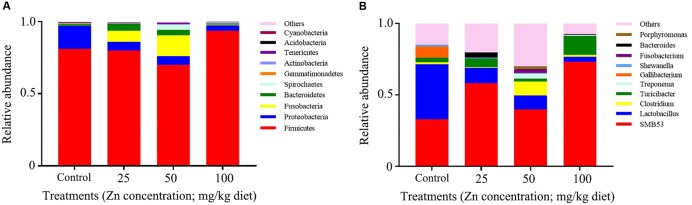
The relative richness of microbiota at phylum and genus level. The representative sequences for each OUT was used to annotate taxonomic information: (A) phylum, (B) genus.